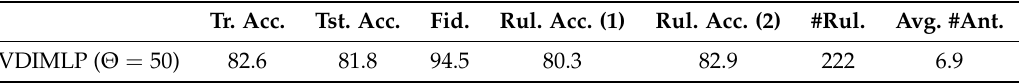
Table 6. Results obtained by a CNN and its approximation with a VDIMLP subnetwork in the top layers. Tr.